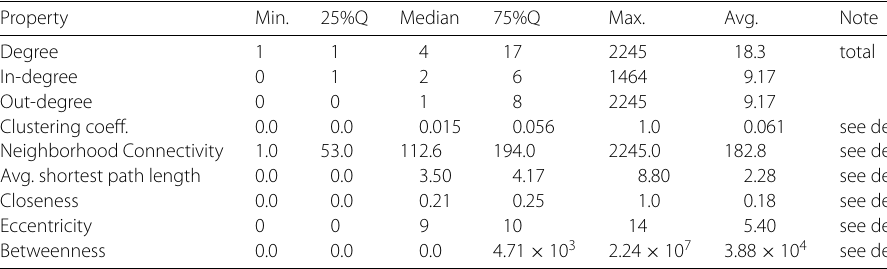
Table A.2 Centralities and properties of nodes Property Min.